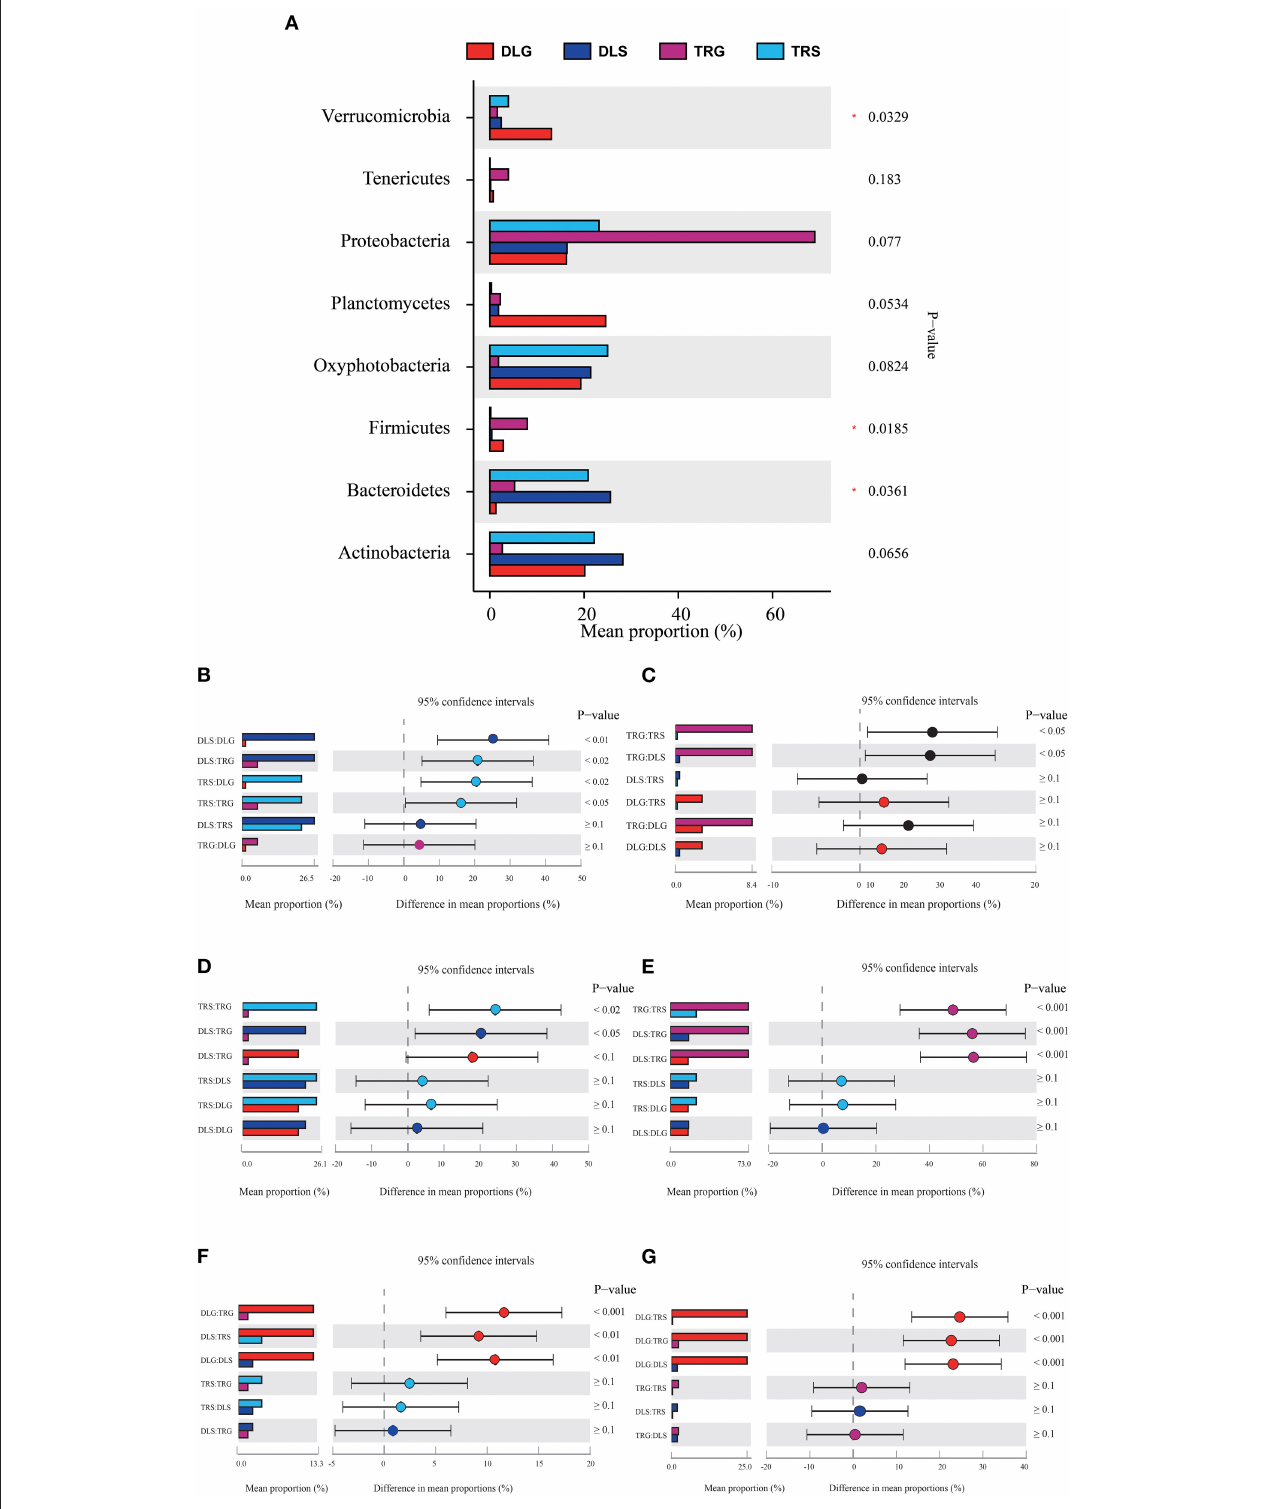
FIGURE 6 | Comparison of bacterial abundances in intestine and water at the alkaline water and freshwater environment at the phylum level (A) . One-way ANOVA bar plot on phylum level for Bacteroidetes (B) , Firmicutes (C) , Oxyphotobacteria (D) , Proteobacteria (E) , Verrucomicrobia (F) , and Planctomycetes (G) . *stands for 0.01 < P ≤